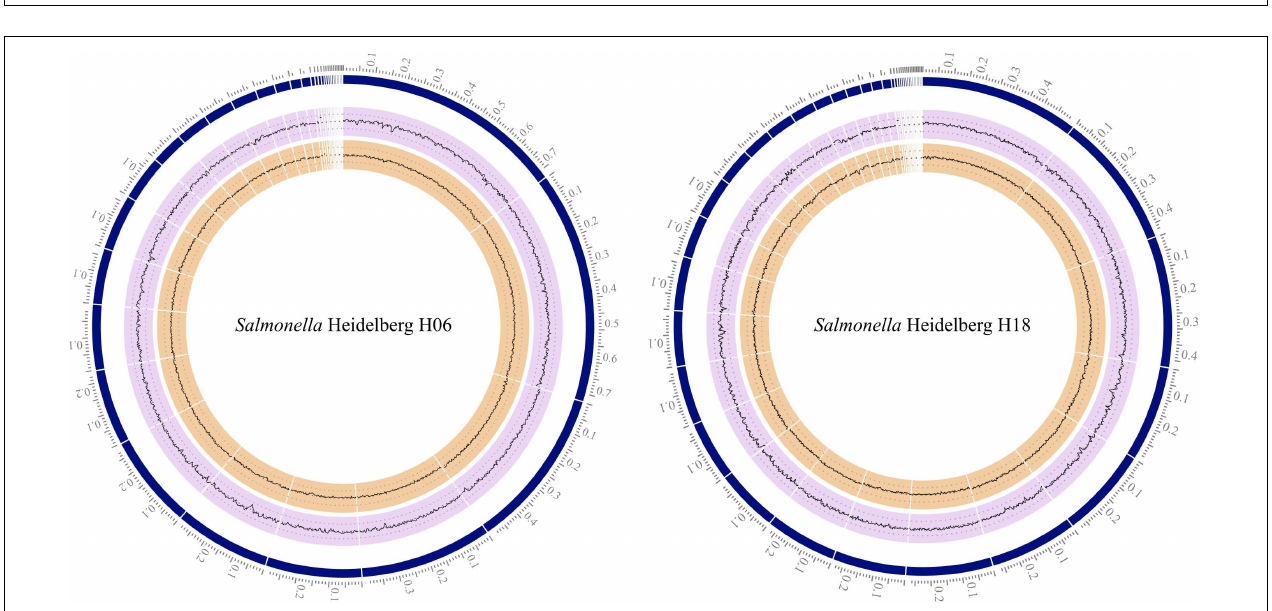
FIGURE 4 | Circular graphical display of the distribution of the contigs of Salmonella Heidelberg H06 and H18 genomes assembly. From outer to inner rings, we present contigs (in Mbp), GC content, and GC skew, produced by Circos